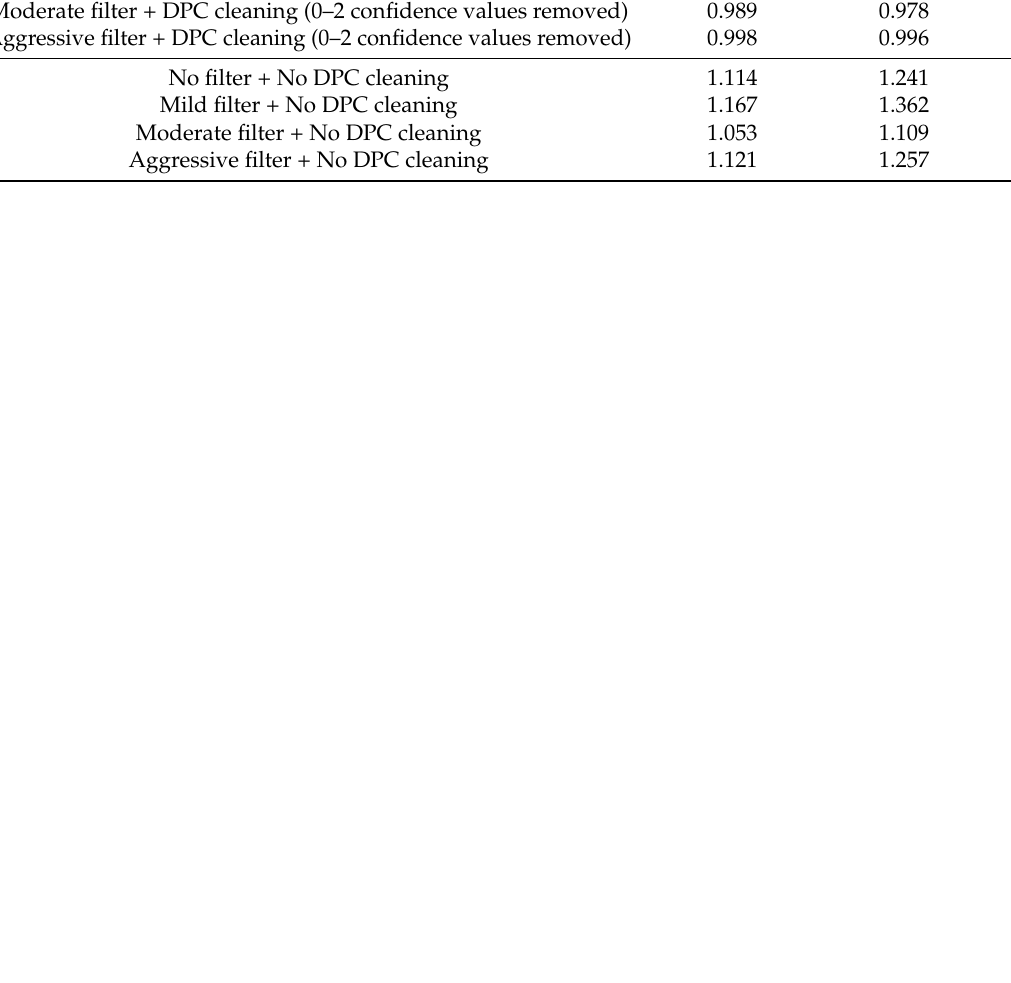
RMSE MAE SDE (Meters) (Meters)